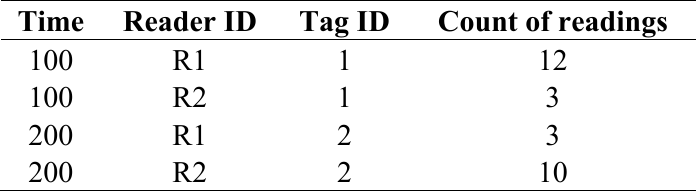
Table 3 . Reading on tag A1 by different readers.